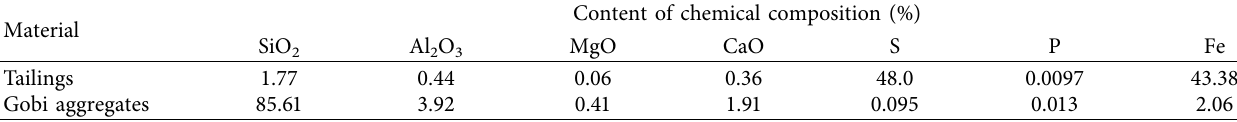
Table 1: Chemical composition of tailings and Gobi